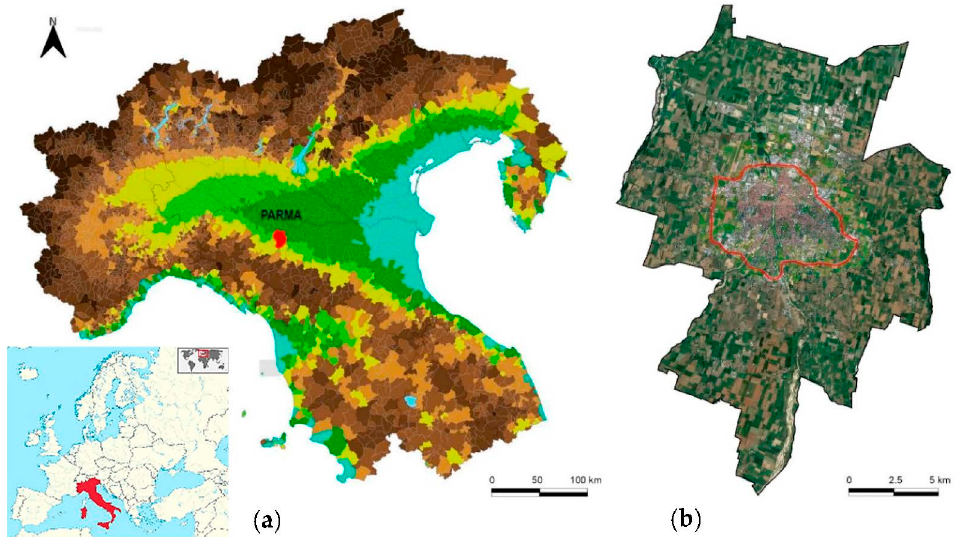
Figure 1. The study area of ( a ) map of Northern Italy showing the location of Parma; ( b ) boundaries of the territory managed by the municipality (urbanized area in red).